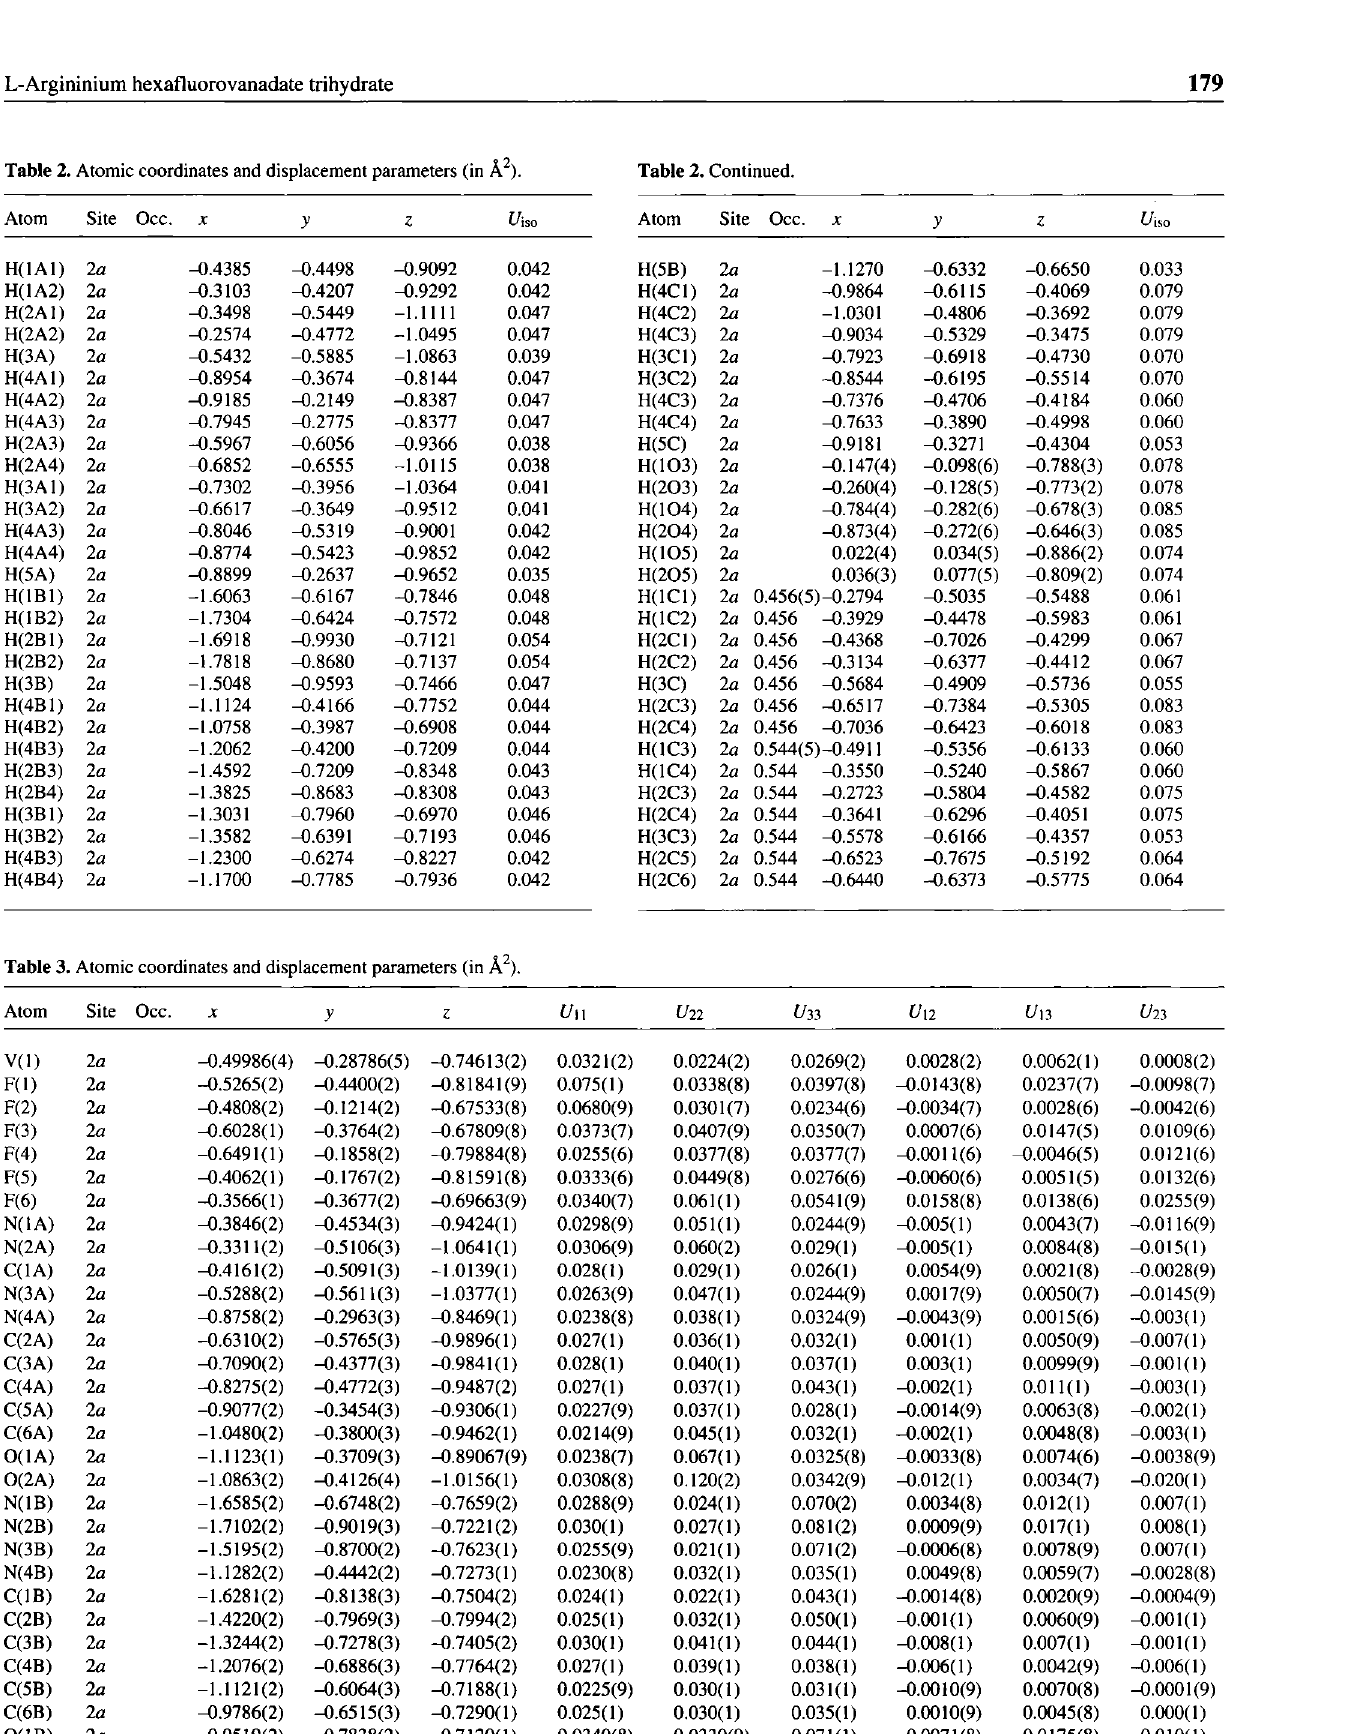
Table 3. Atomic coordinates and displacement parameters (in Ä 2